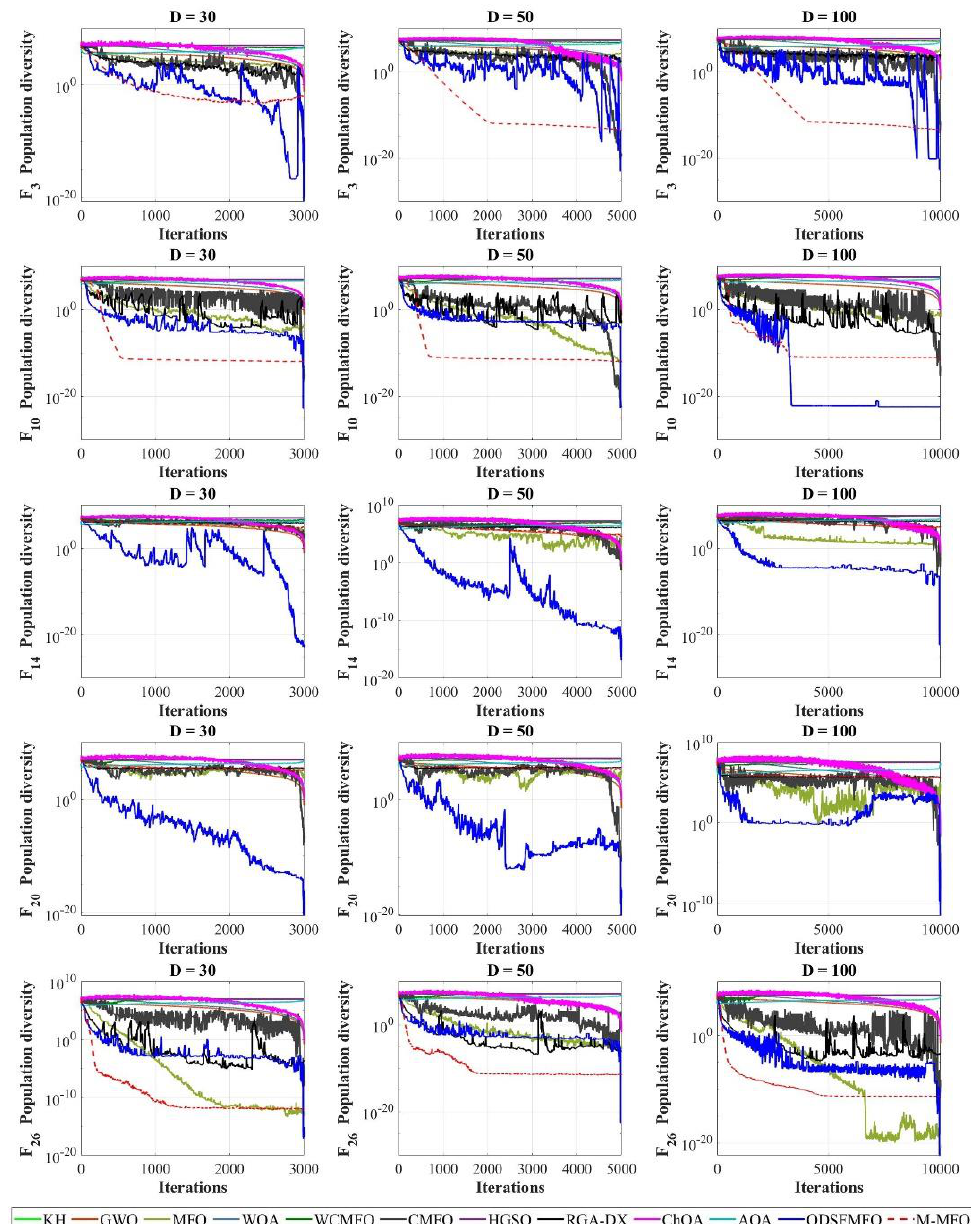
Figure 5. Population diversity of M-MFO and contender algorithms on different dimensions.